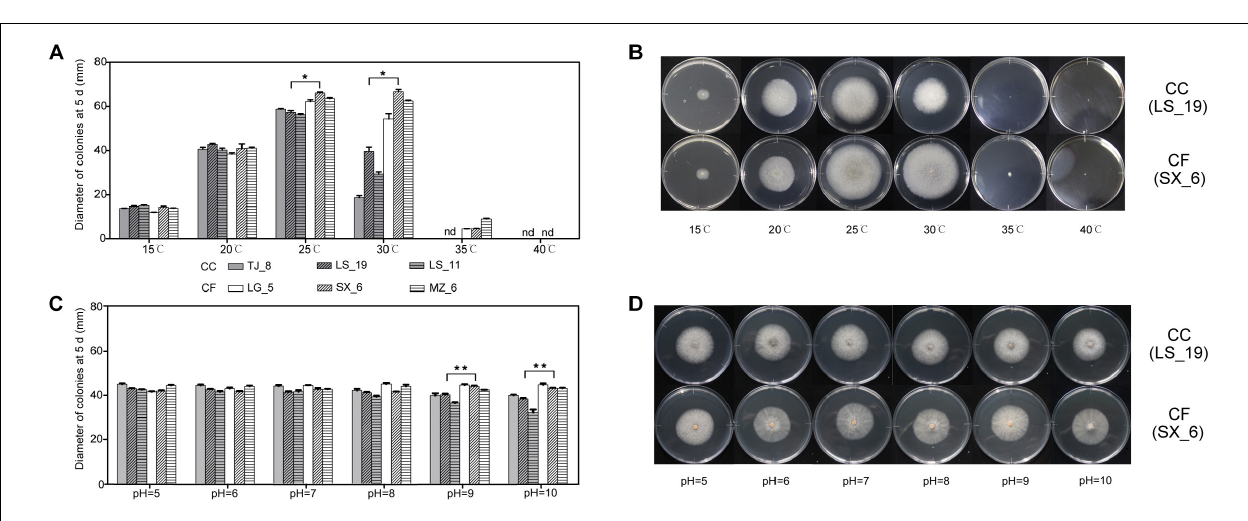
Frontiers in Microbiology |